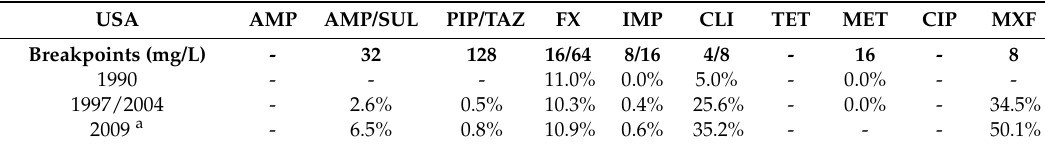
Table 7. Resistance trends of clinical Bacteroides isolates in the United States between 1990–2009 (expressed as the percentage of resistant isolates)